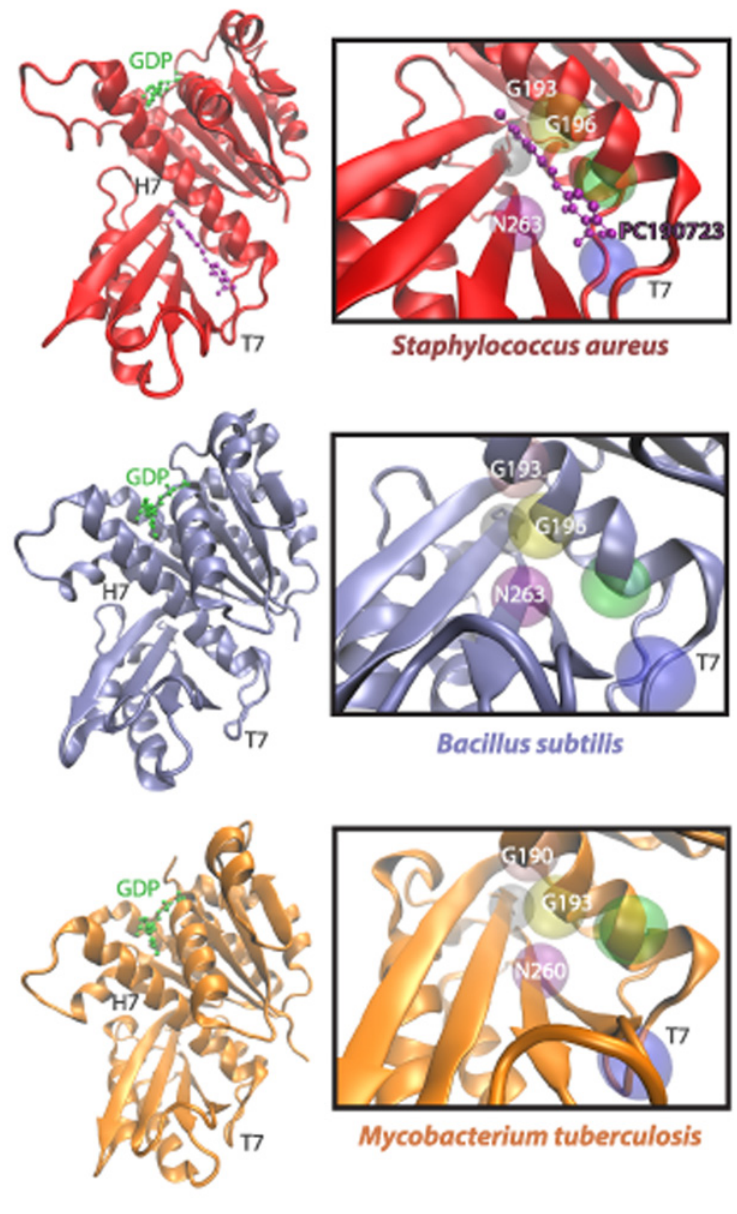
Fig 1. The FtsZ PC190723-binding pocket differs structurally across bacterial species. PC190723 binds a cleft beneath the H7 helix and adjacent to the T7 loop of FtsZ, as demonstrated in an Sa FtsZ-PC197023 co-crystal (PDB ID: 4DXD) [17], in a B . subtilis FtsZ (PDB ID: 2RHL) structure [42], and in a Mycobacterium tuberculosis FtsZ (PDB ID: 1RQ7) structure [43]. Highlighted above are a few of the 20 amino acid residues that are within 6 Å of PC190723, including G193, G196, and N263, which induce drug resistance when mutated in Sa FtsZ.